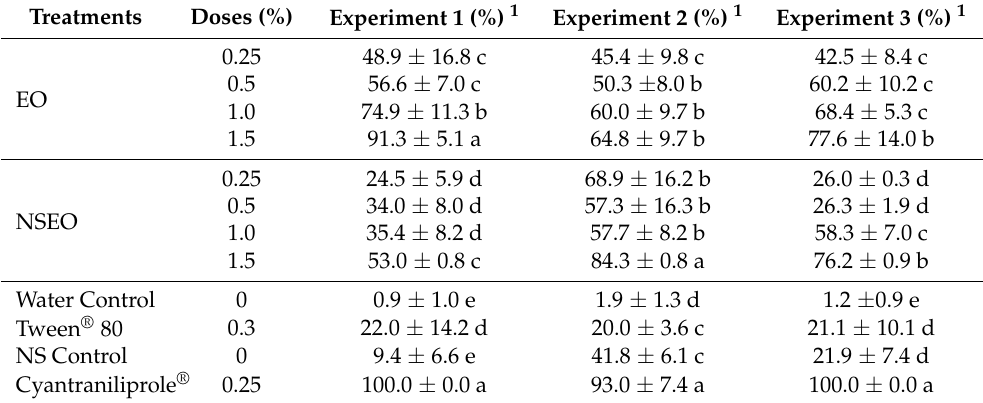
Figure 3. Mortality of 2nd-instar nymphs of B. tabaci after application of essential oil in the free (EO) and nanoencapsulated (NSEO) forms at different concentrations for experiment 1 ( a ), experiment 2